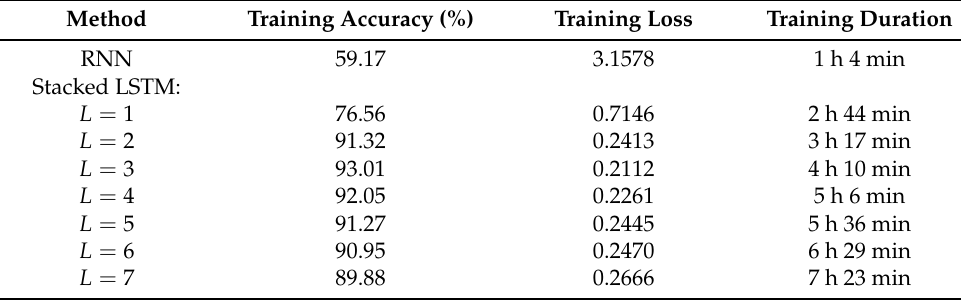
Table 11. Training performances using F4